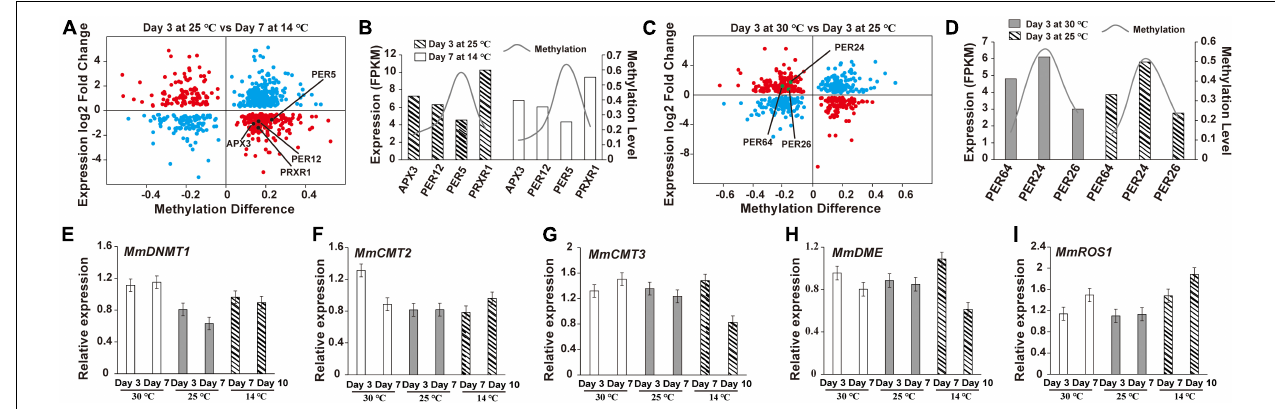
FIGURE 8 | Expression and methylation patterns of cold-responsive genes during the germination of M. micrantha seeds. (A) Correlations between gene expression and methylation expression levels in the comparison of the 3 rd day at 25 ◦ C and the 7 th day at 14 ◦ C. X-axis represents the DNA methylation difference, and y-axis represents the genes expression log2 fold change. The blue plot indicates no association; the red plot means there exists an association. (B) Changing tendency between a methylation level and FPKM of genes identified from the comparison of the 3 rd day at 25 ◦ C and the 7 th day at 14 ◦ C. (C) Correlations between gene expression and methylation expression levels between the 3 rd day at 30 and 25 ◦ C. (D) Changing tendency between the methylation level and FPKM of genes identified from the comparison of the 3 rd day at 25 and 30 ◦ C. Relative expression of methyltransferase genes (E–G) and demethylation-related genes (H,I) performed using qRT-PCR.